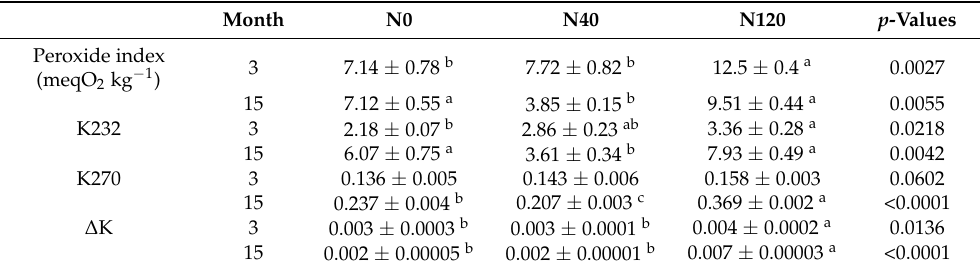
Table 4. Olive oil quality indices (samples from the harvest of 2018 after 3 and 15 months of storage) from olive trees supplied with 0 (N0), 40 (N40) and 120 (N120) kg ha − 1 of